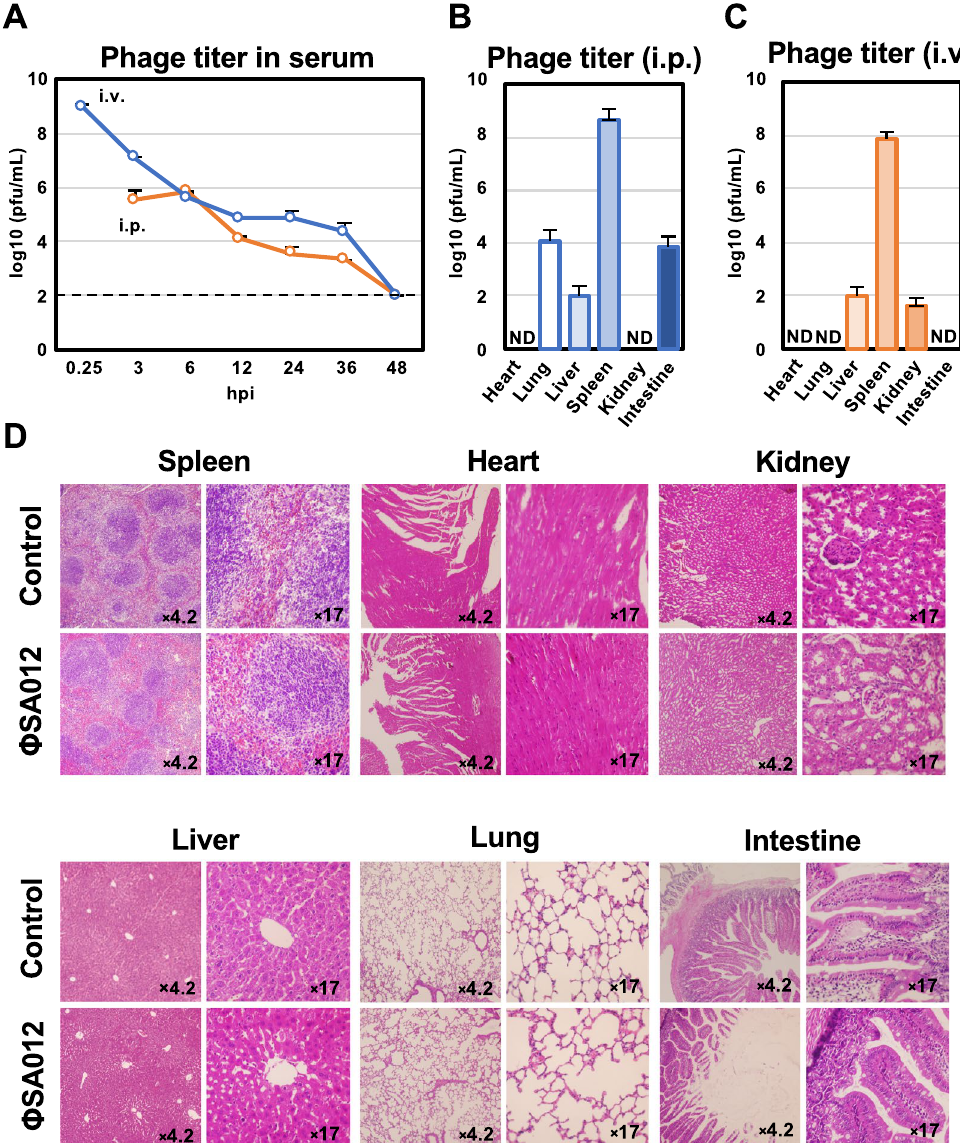
Figure 4. Pharmacokinetics and side effects of ΦSA012 in mice. ( A ) Pharmacokinetics of ΦSA012 administered with i.p. and i.v. injections into mice. Phage titers in the serum were monitored from 3 to 48 hpi for i.p. and from 0.25 hpi to 48 hpi for i.v. injections. The titers of ΦSA012 in serum samples are presented as means ± SD (n = 3). 10 2 pfu/mL is the limit of detection of the phage in the plaque assay. ( B ) Accumulation of ΦSA012 in organs at 48 hpi after i.p. injection. The titers of ΦSA012 in organ homogenates are presented as means ± SD (n = 3). ( C ) Accumulation of ΦSA012 in organs at 48 hpi after i.v. injection. The titers of ΦSA012 in organs homogenates are presented as means ± SD (n = 3). ND means that plaques were not detected, indicating values less than 1.2 × 10 2 pfu/g in the heart, 8.9 × 10 1 pfu/g in the lung, 4.5 × 10 2 pfu/g in the kidney, and 8.7 × 10 1 pfu/g in the intestine. ( D ) Histopathology and pathological changes of organs in ΦSA012-inoculated mice (i.p.). The spleens, hearts, kidneys, livers, lungs, and intestines were stained with hematoxylin and eosin. The number in each picture represents